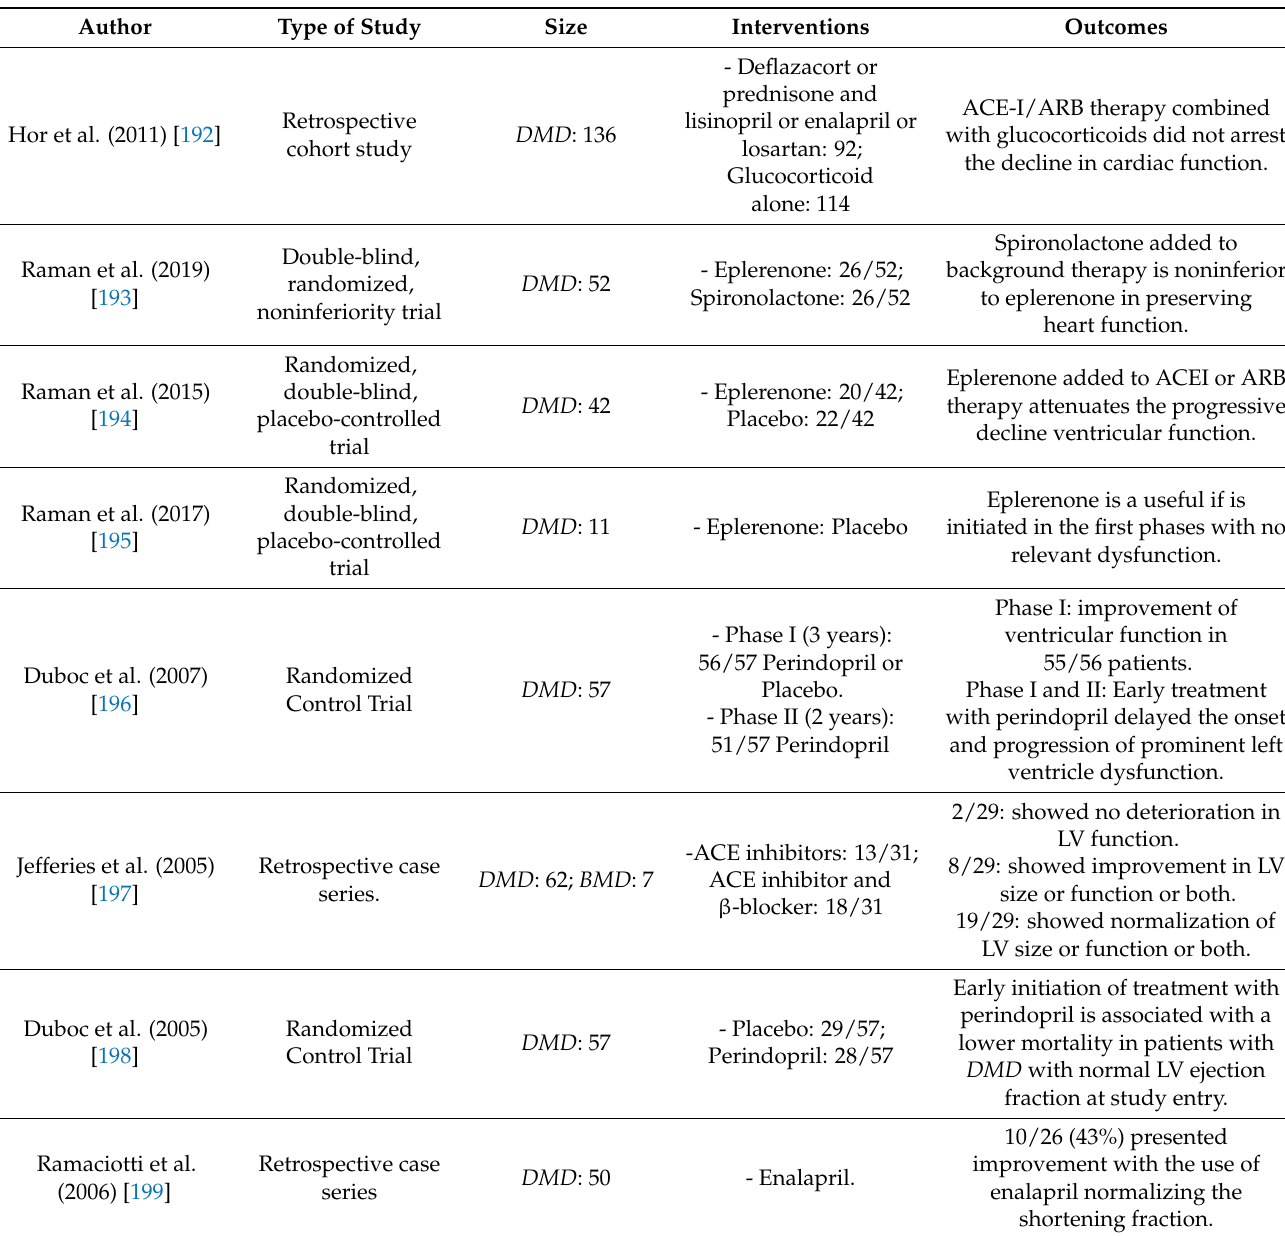
Table 3. Summary of the different investigations in humans about the inhibition of the RAAS and DDC